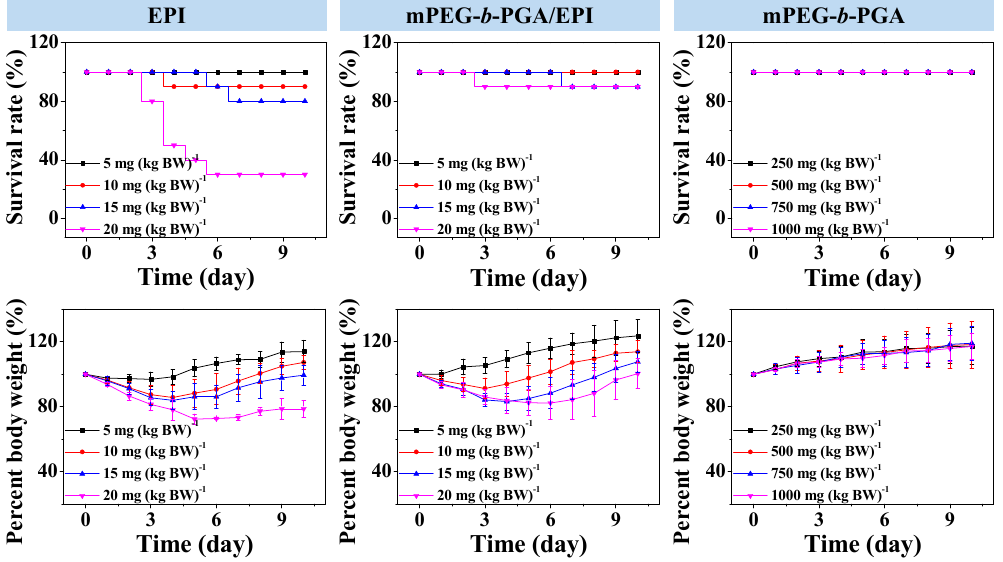
Figure 7. Survival rates and percent body weights of Kunming mice after intravenous injection of free EPI or mPEG- b -PGA/EPI at EPI equivalent dose of 5.0, 10.0, 15.0, or 20.0 mg·(kg·BW) − 1 , or mPEG- b -PGA at dose of 250.0, 500.0, 750.0, or 1000.0 mg·(kg·BW) − 1 ( n = 10).